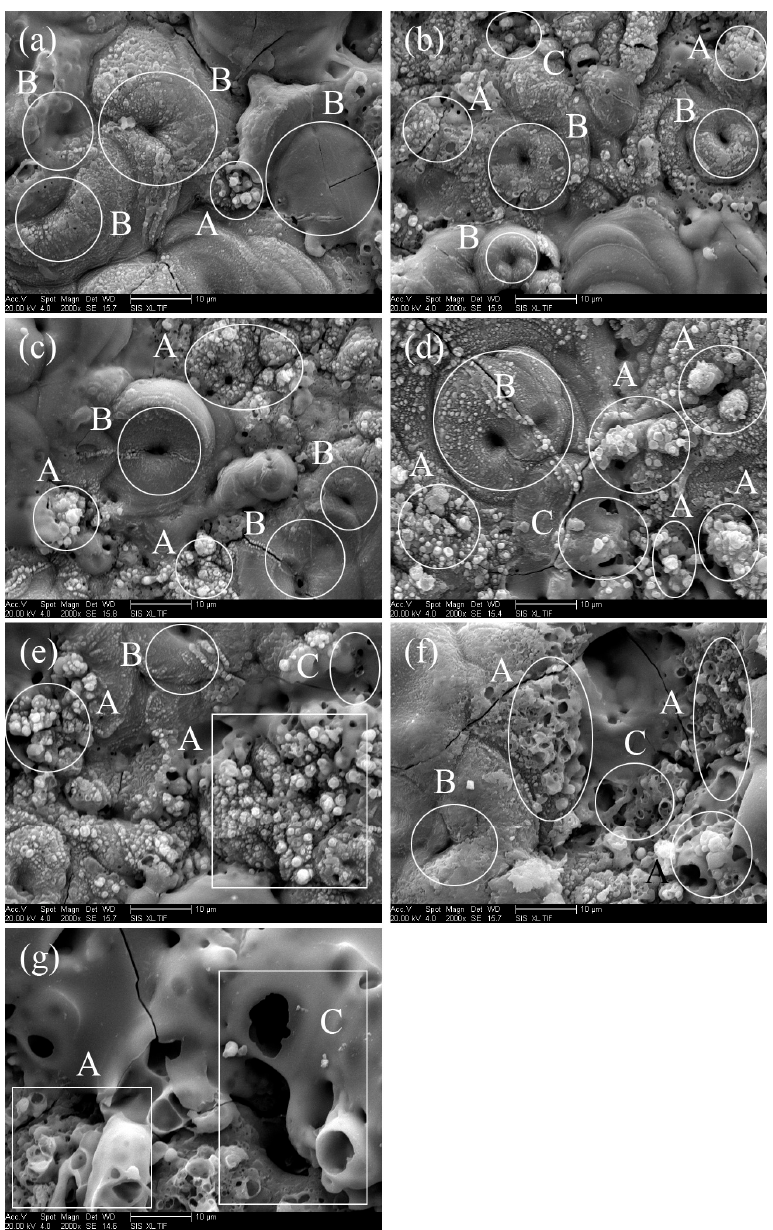
Figure 3. Surface morphologies of the microarc oxidation coatings formed on aluminum alloys at different anode pulse-widths. ( a ) 1000 μ s; ( b ) 1500 μ s; ( c ) 2000 μ s; ( d ) 2500 μ s; ( e ) 3000 μ s; ( f ) 3500 μ s; ( g ) 4000 μ s.